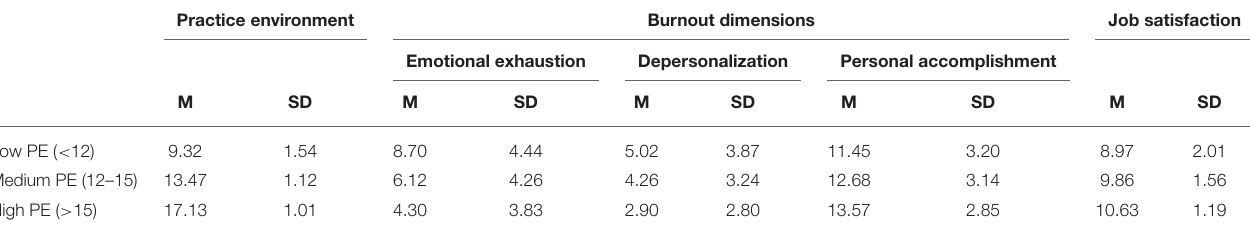
TABLE 3 | Descriptive statistics of practice environment, burnout dimensions and job satisfaction of the groups with low, medium and high levels of practice environment. Practice environment Burnout dimensions Job satisfaction Emotional exhaustion Depersonalization Personal